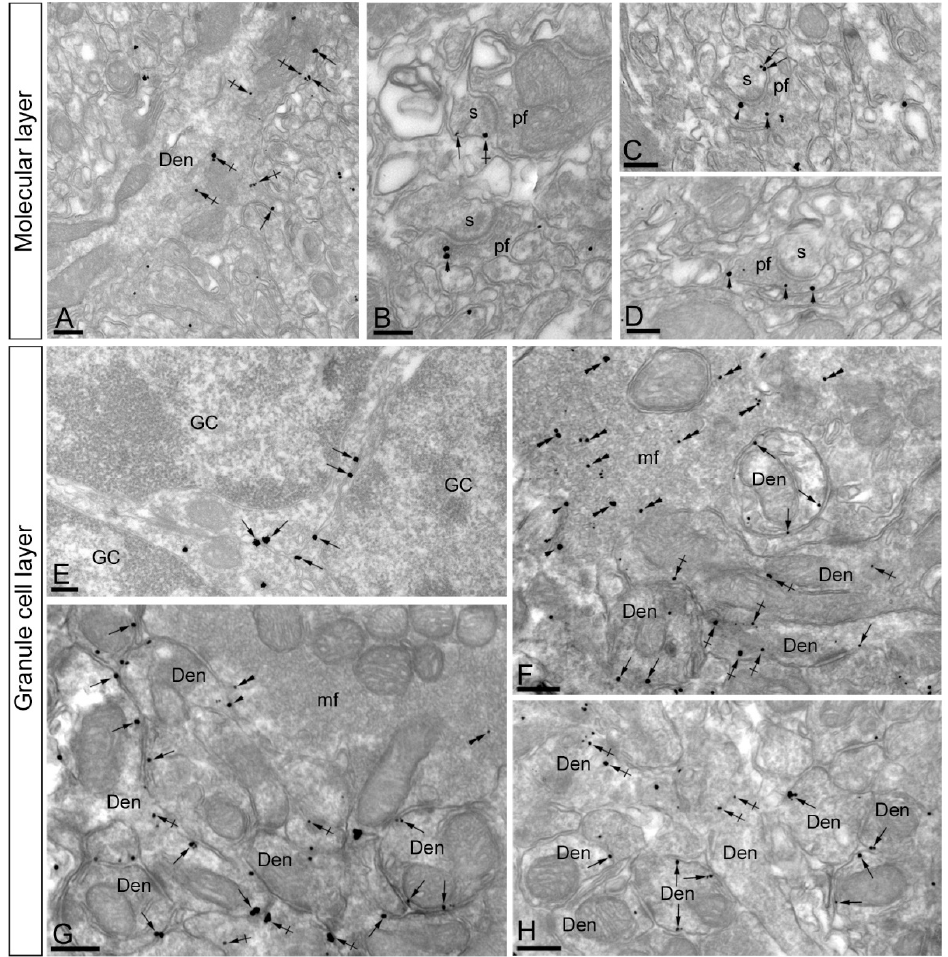
Figure 3. Subcellular localisation of Kv channel interacting protein (KChIP) subunit KChIP3 in the cerebellum. Electron micrographs showing immunoparticles for KChIP3 in the cerebellar cortex, as detected using the pre-embedding immunogold technique. ( A – D ) In dendritic shafts (Den) and spines (s) of PCs, located in the molecular layer, KChIP3 immunoparticles were observed postsynaptically along the extrasynaptic plasma membrane (arrows). Less frequently, KChIP3 immunoparticles were observed intracellularly (crossed arrows). Presynaptically, KChIP3 immunoparticles were detected along the extrasynaptic membrane and at intracellular sites (arrowheads) of parallel fibres (pf). ( E – H ) In the granule cell layer, KChIP3 immunoparticles were observed along the somatic plasma membrane (arrows) and dendrites (Den, arrows) and intracellular sites (crossed arrows) of granule cells (GC). Presynaptically, KChIP3 immunoparticles were observed along the plasma membrane (arrowheads) of mossy fibre axon terminals (mf), but most of them were localised intracellularly (double arrowheads) associated with cytoplasmic membranes. Scale bars: A – C , 200 nm; D – H , 250 nm. To quantitatively assess the localisation of KChIP3 in the cerebellar cortex, we first calculated the proportion of immunoparticles in the plasma membrane and at intracellular sites (Figure 4). From 1487 immunogold particles analysed in the molecular layer, 567 (38.1%) were distributed at postsynaptic sites and 920 (61.9%) at presynaptic sites (Figure 4A). Postsynaptically, 78,3% of all KChIP3 immunoparticles were in dendritic shafts and, of those, 27.9% were located on the plasma membrane and 72.1% at intracellular sites (Figure 4A). In contrast, 21.7% of all KChIP3 immunoparticles were in dendritic spines, with 49.6% of these particles being located on the plasma membrane and 50.4% at intracellular sites (Figure 4A). Presynaptically, from 920 immunogold